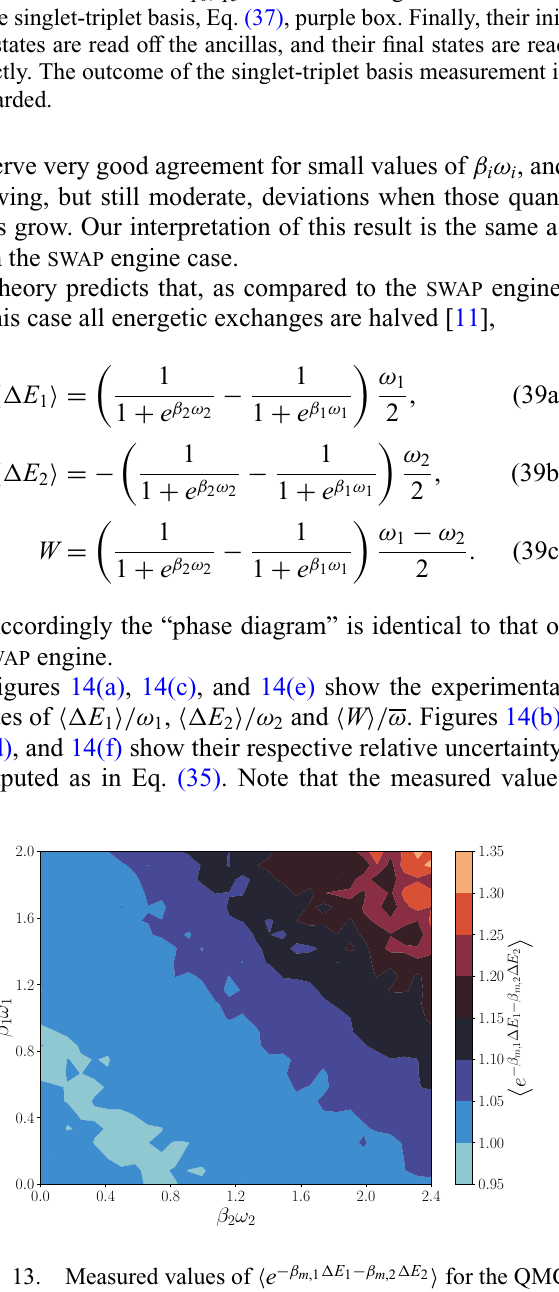
FIG. 13. Measured values of (cid:5) e − β m ,1 (cid:10) E 1 − β m ,2 (cid:10) E 2 (cid:2) for the QMC engine design in Fig. 12 as a function of nominal inverse rescaled temperatures β 1 ω 1 , β 2 ω 2 .